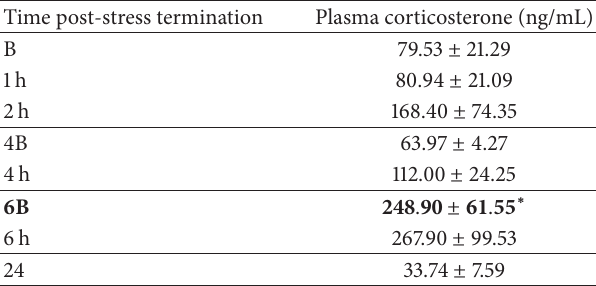
Table 2: Circulating